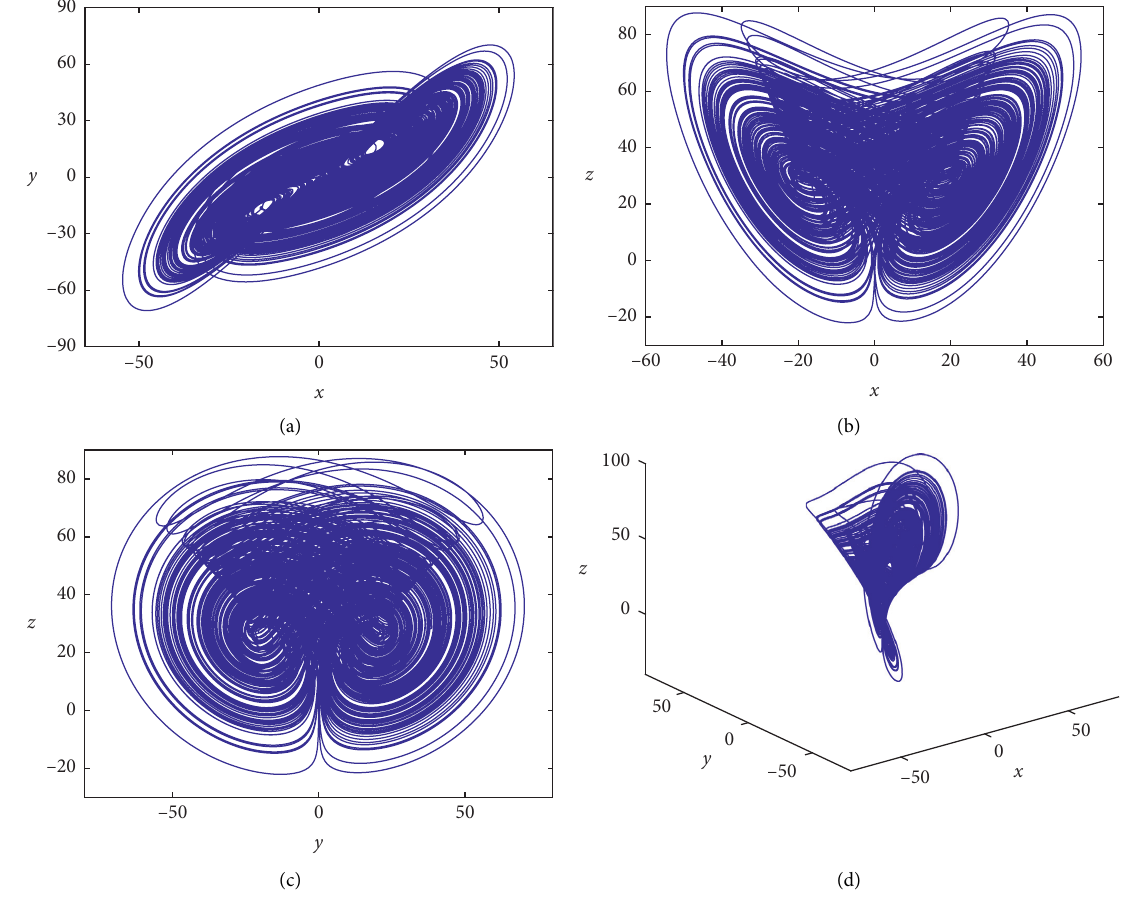
Figure 6: Phase diagrams of the system based on the tri-valued memristor: (a) x - y , (b) x - z , (c) y - z , and (d) x-y-z .